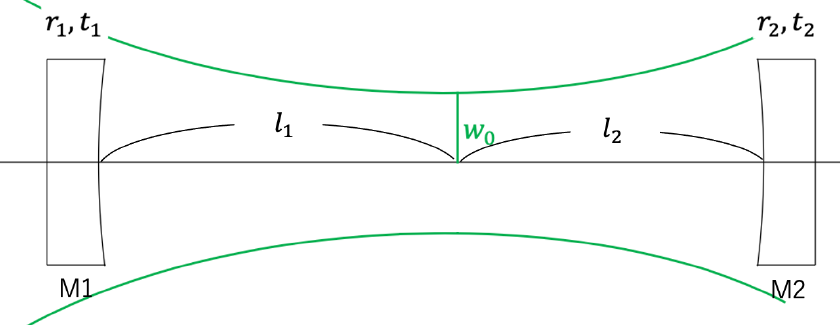
Figure 2. Configuration of the light around the FP cavity. The cavity has two mirrors. M1 is the input mirror with reflectivity of r 1 , transmissivity of t 1 , and radius R 1 . M2 is the end mirror with reflectivity of r 2 , transmissivity of t 2 , and radius R 2 . w 0 is the beam size at the beam waist. The distance from the mirrors to the beam waist are l 1 and l 2